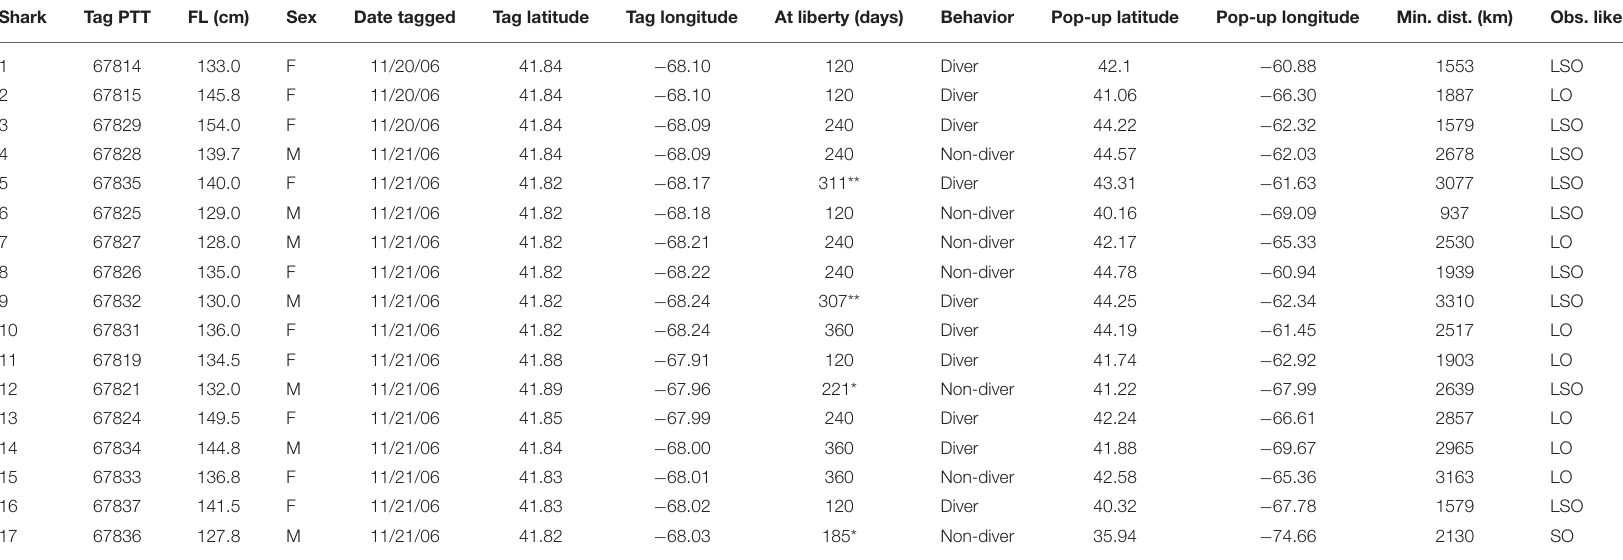
Min. dist., Minimum linear distance (km) calculated as sum of daily track segments; Obs. like., Observation likelihood, which indicates observations used in HMMoce to construct the most probable track: L, light-based longitude; S, sea surface temperature; O, integrated ocean heat content. Asterisks indicate premature release of tags programmed for 240 ( * ) and 360 ( ** )